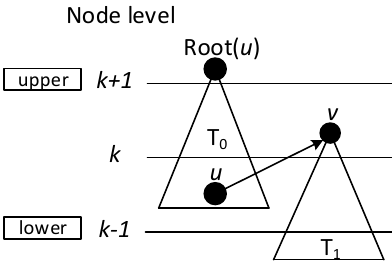
Figure 9. Case 1 in finalizing backbone.